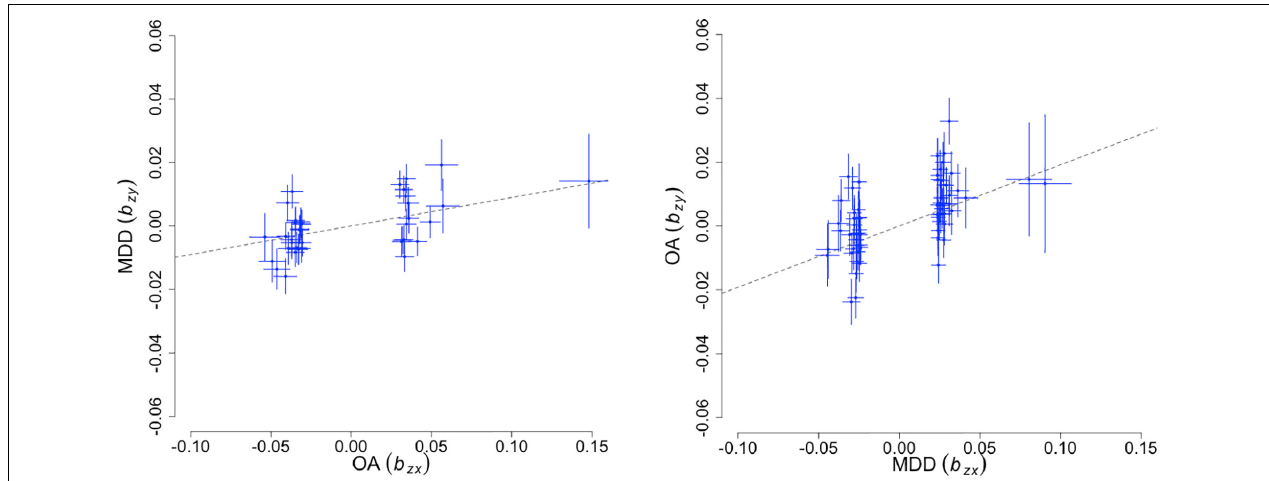
FIGURE 2 | Bidirectional Mendelian randomization analysis results. The X-axis represents the estimated effect of the SNPs associated with the exposure ( ˆ b zx ), while the Y-axis represents the estimated effect of the same SNPs on outcome ( ˆ b zy ). Each cross marks independent instruments (i.e., SNPs) used to test for causality. The ratio, ˆ b zy / ˆ b zx is an estimate of the mediation effect of the exposure on the outcome assuming that under a causal model, if an exposure has a causal effect on an outcome, all instruments causally associated with the exposure will have an effect on the outcome expected to be